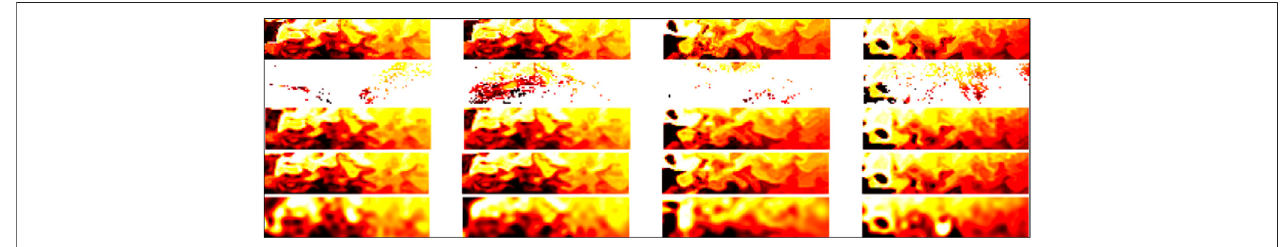
FIGURE 5 | Interpolation examples for SST data used during training: the fi rst row, reference SST images corresponding to the center of the considered 11-day time window; the second row, associated SST observations with missing data; the third row, interpolation issued from the FP(15)-GENN 2 model; and the last row, reconstruction of the gap-free image series issued from the FP(15)-GENN 2 model; interpolation issued from an OI scheme using a Gaussian covariance model with empirically tuned parameters.